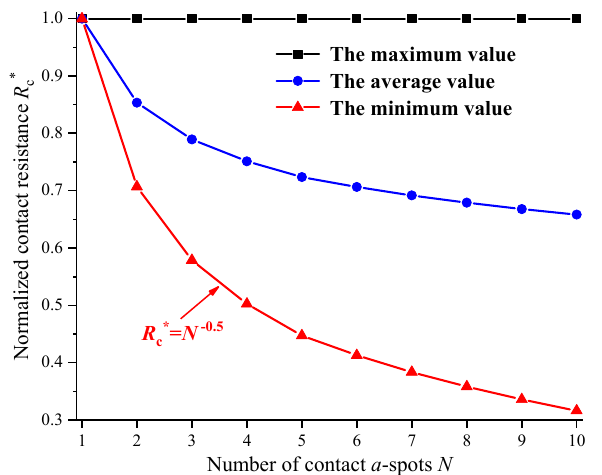
Figure 9. The variations in the minimum, average and maximum normalized contact resistance as a function of the number of contact a -spots.